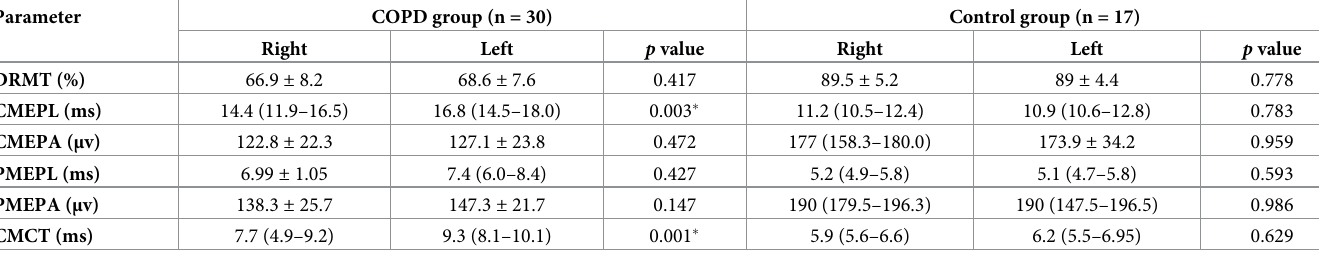
Table 3. Comparison between right and left diaphragmatic CMEPs and PMEPs in both